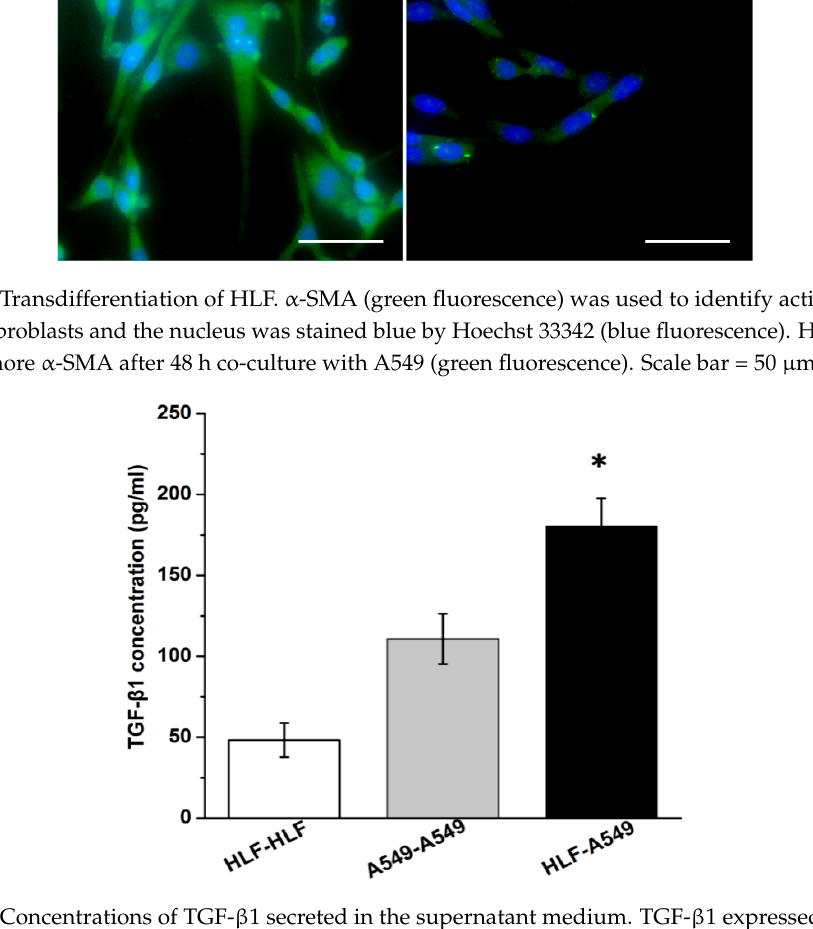
Figure 8. Concentrations of TGF- β 1 secreted in the supernatant medium. TGF- β 1 expressed by both